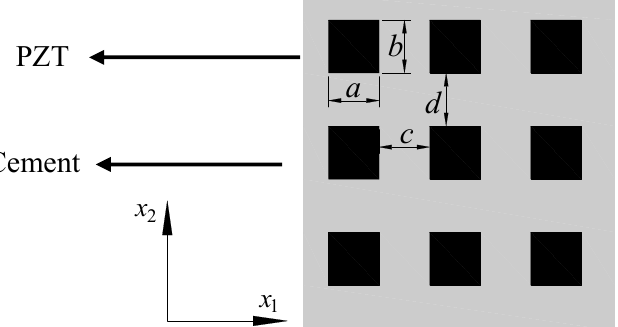
Materials 2018 , 11 , x FOR PEER REVIEW Figure 9. Planar schematic of the 1-3 type cement-based piezoelectric composite.